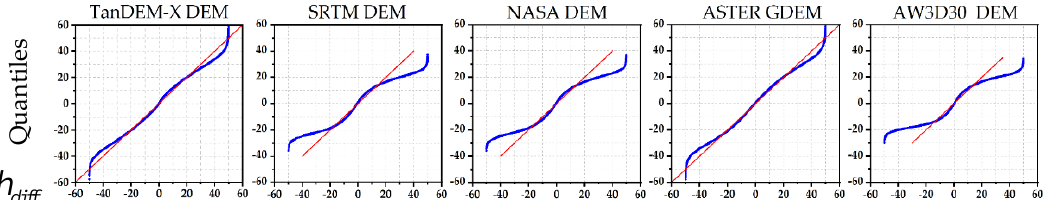
Figure 4. The Q−Q diagram of the normality test of residuals. ℎ diff is the height difference between the DEM products on top of the subfigures and the ICESat/GLAS data. The red line is the case of the ideal normal distribution. The blue line shows the actual situation of each DEM product. The Q-Q plot (blue line) of each DEM product deviates from the graph of the ideal normal distribution (red line), indicating a non-normal distribution. Therefore, we